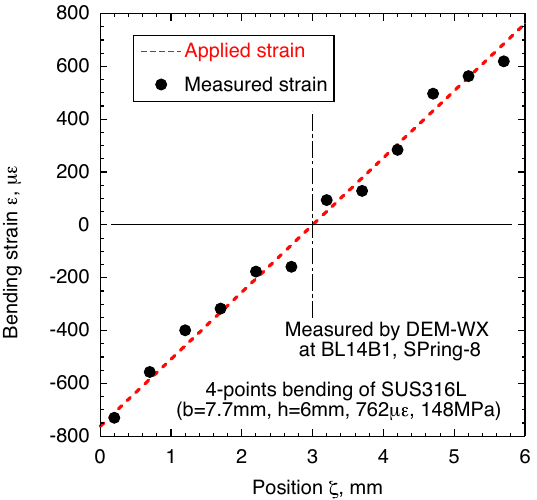
Figure 13. Strain distribution measured using DEM with white X-rays. The DEM is the double-exposure